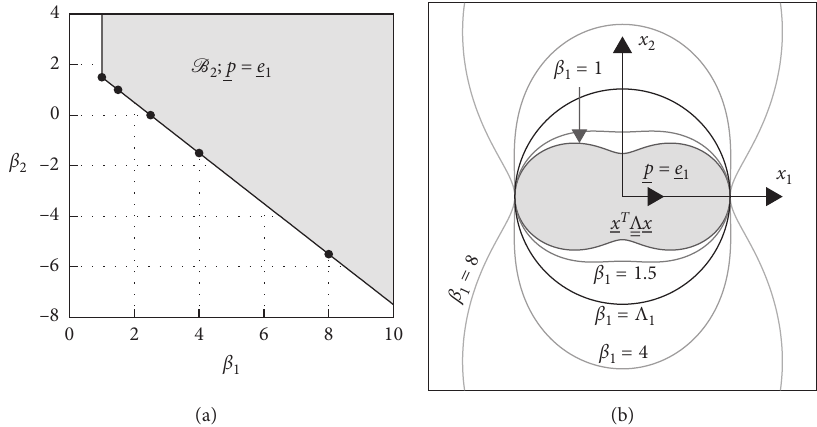
x in the (1,2)-plane for all normalized 2